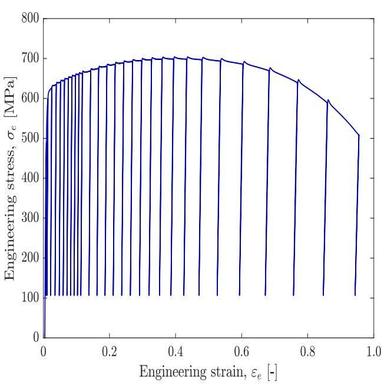
Engineering stress - engineering strain history of the elastic modulus monitoring test.